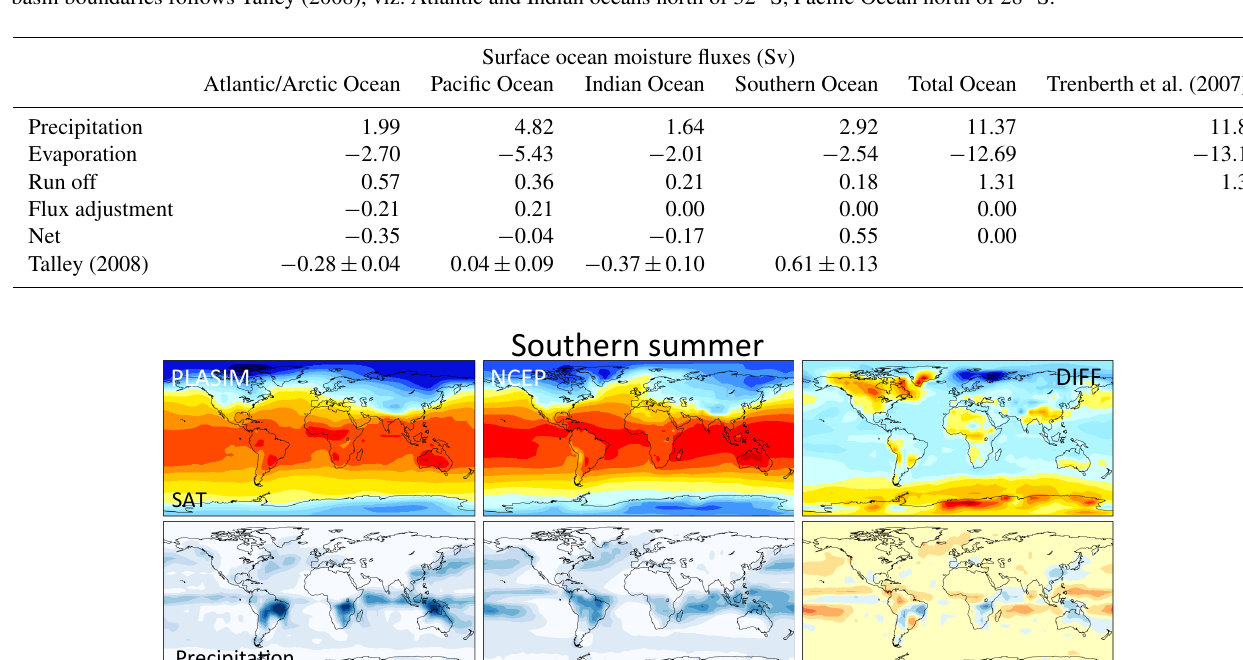
Table 3. Simulated surface ocean moisture fluxes of the subjective tuning and observationally constrained estimates. The definition of ocean basin boundaries follows Talley (2008), viz. Atlantic and Indian oceans north of 32 ◦ S, Pacific Ocean north of 28 ◦ S.